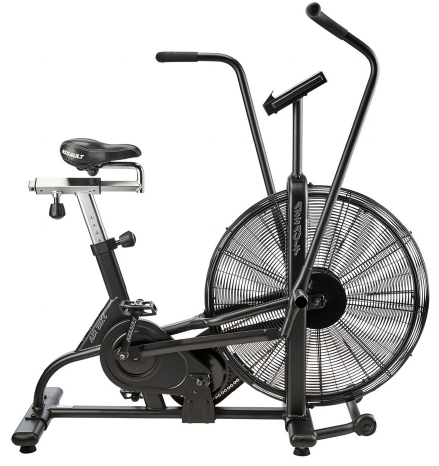
Figure 2. Assault